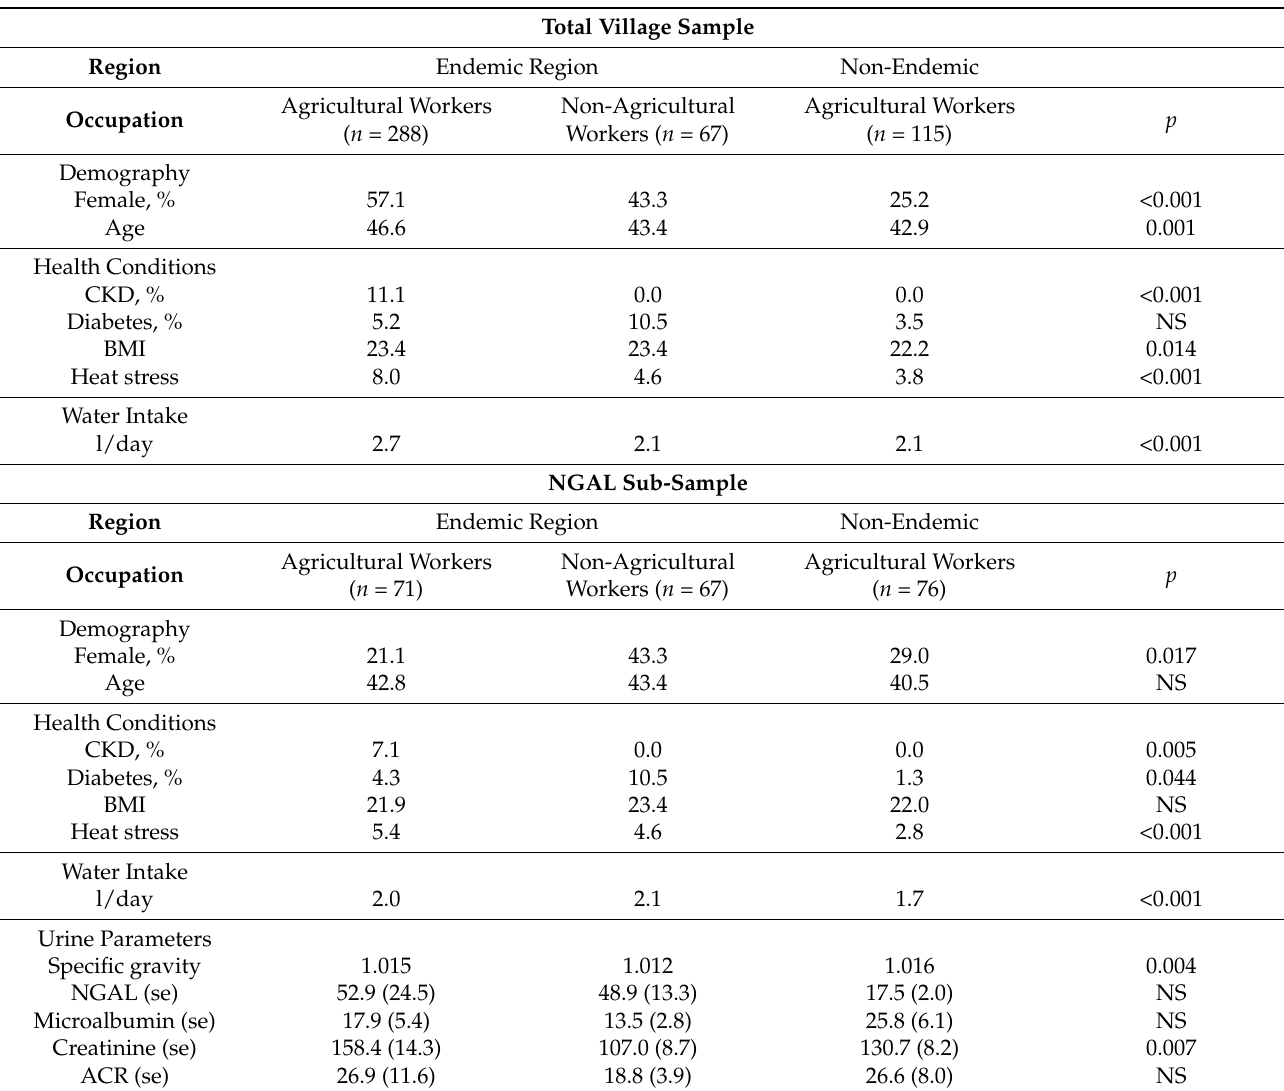
Table 2. Total village sample and NGAL sub-sample. Total Village